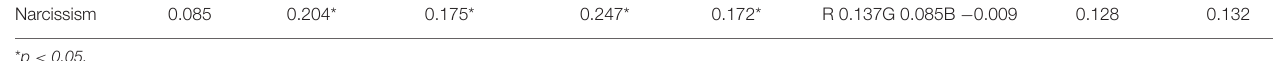
TABLE 2 | Correlations between narcissism and a part of high- and low-level features of Instagram photographs. N. of Photos